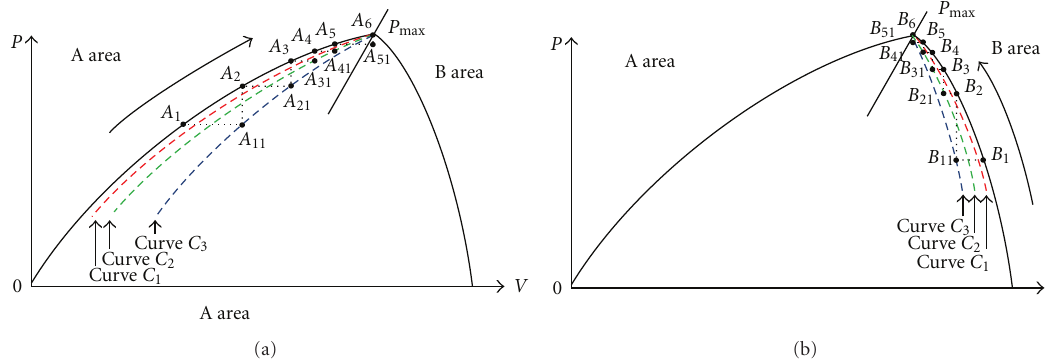
Figure 7: Illustration of PV arrays operated in (a) A area and (b) B area for MPPT.